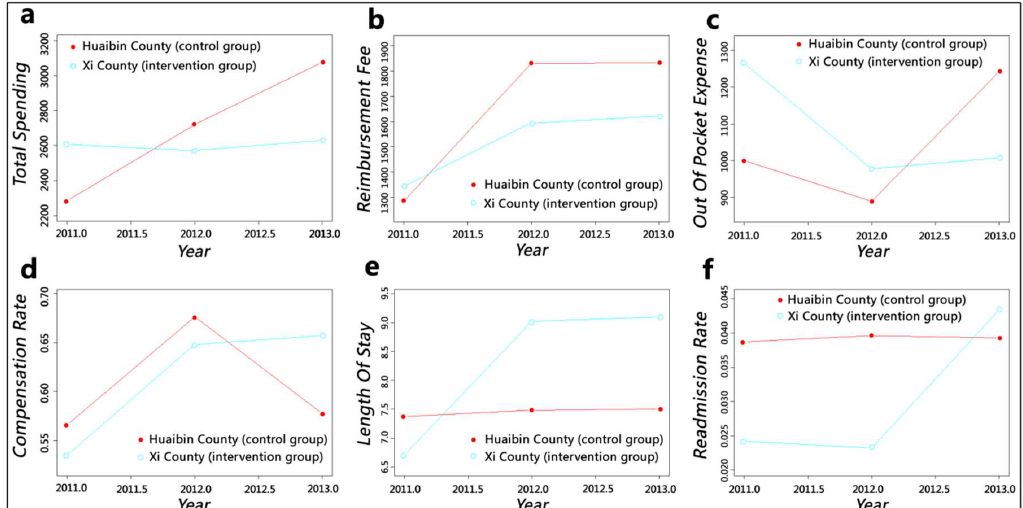
Figure 2. Smooth curves fitting for the whole county level: ( a ) adjusted mean of total spending; ( b ) adjusted mean of reimbursement fee; ( c ) adjusted mean of out-of-pocket expense; ( d ) adjusted mean of compensation ratio; ( e ) adjusted mean of length of stay; ( f ) adjusted mean of readmission rate.